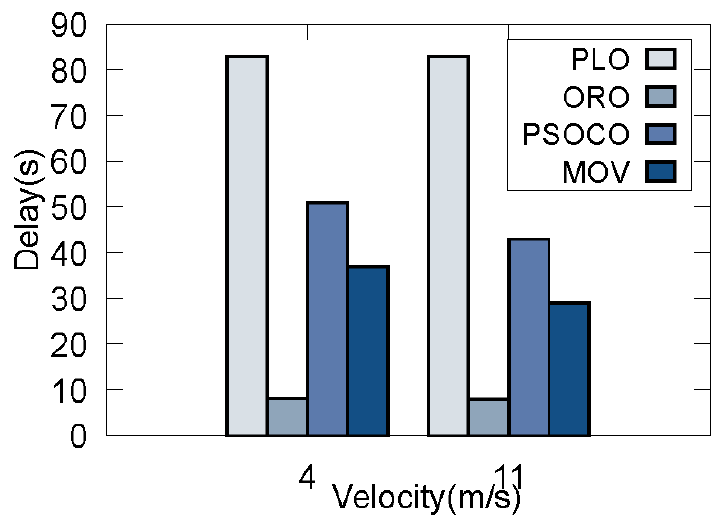
Figure 8. Results of different velocities on delay.